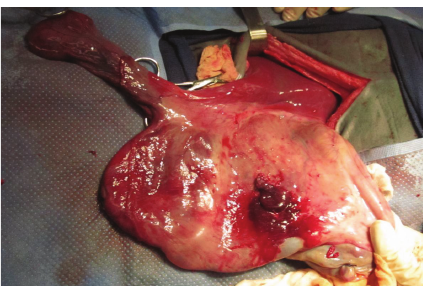
Figure 3: Exteriorization of the cyst capsule after removal of the cystic fluid. Cyst originated from the caudal border of the right liver